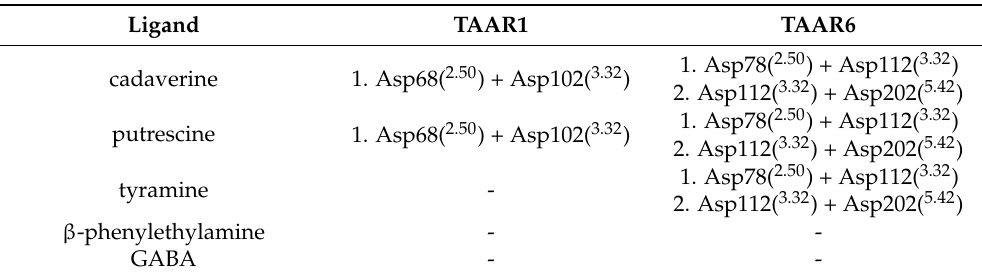
Table 4. Amino acid residues TAAR1 and TAAR6, which are included in the sites of interaction with ligands.